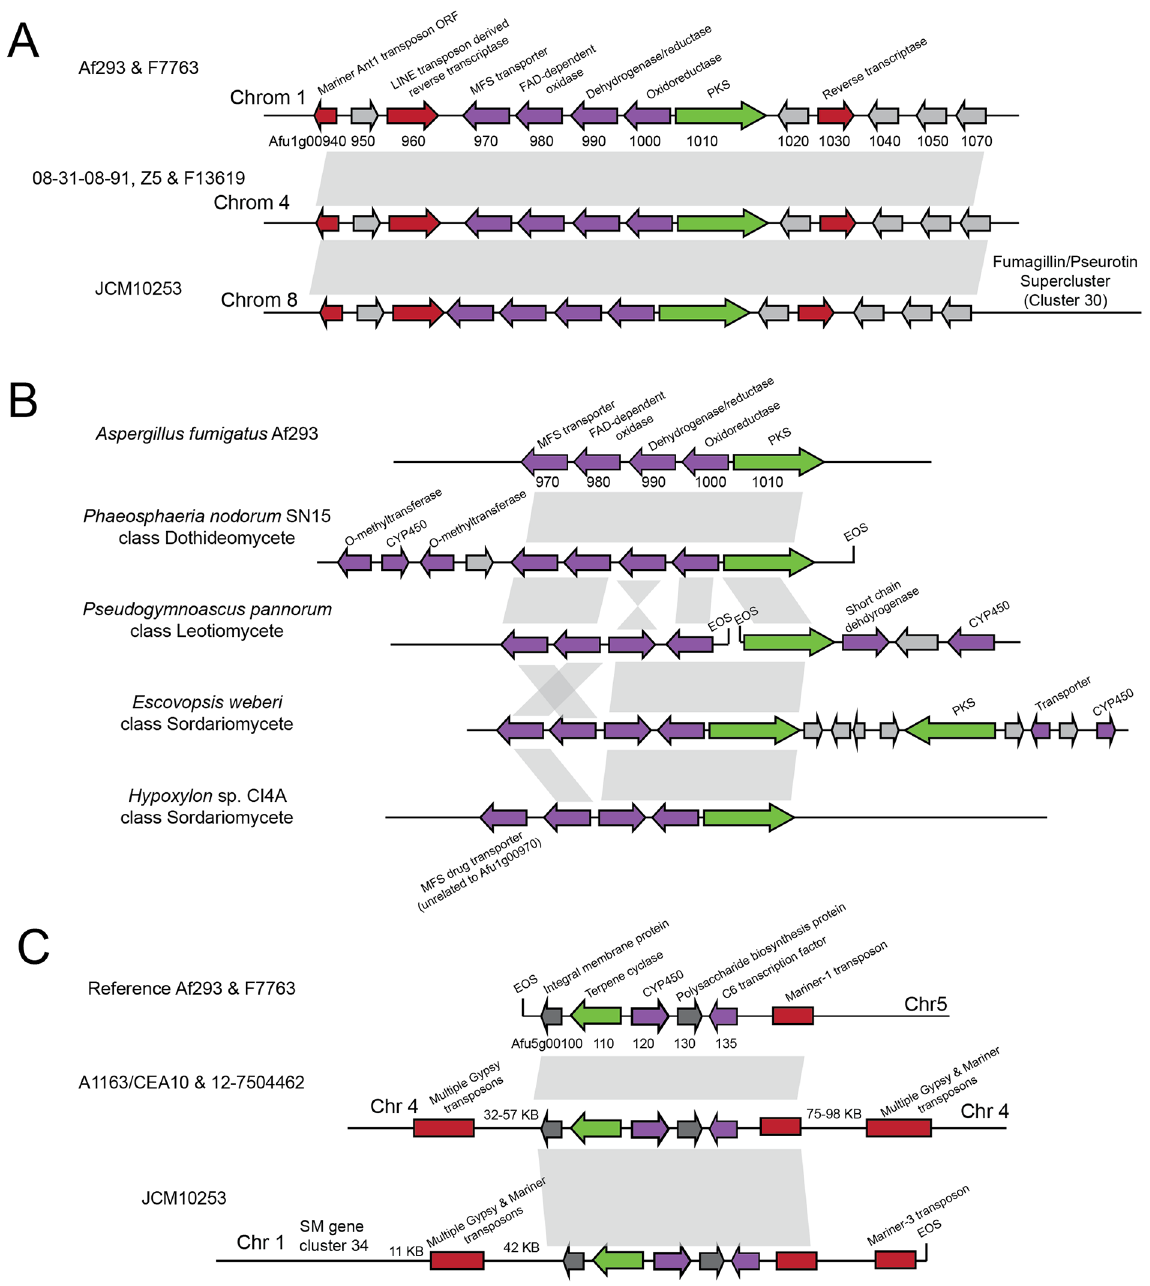
Fig 5. Multiple genomic locations of 2 SM gene clusters. (A) SM genecluster 1 (Afu1g00970-01010) and flankingregionare found in different genomiclocations.The flankingregions containtransposon-derived open readingframes, including2 putative reverse transcriptases. In one strain, SM gene cluster 1 is found adjacentto SM gene cluster 30. (B) Synteny of A . fumigatus SM gene cluster 1 with clusters in Phaeosphaeria nodorum , Pseudogymnoascuspannorum , Escovopsis weberi ,and Hypoxylon sp. CI4A. All species containnonsyntenic genespredictedby antiSMASH to be part of a biosyntheticgene cluster. (C) SM gene cluster 33 (Afu5g00100-00135)is found in different genomiclocationsin different strains. In one strain, the cluster is adjacent to SM gene cluster 34. Multipletransposable elementsflank the cluster in each strain. EOS, end of scaffold; FAD, flavin adeninedinucleotide; MFS, major facilitator superfamily; ORF, open readingframe; PKS, polyketidesynthase; SM, secondarymetabolite.